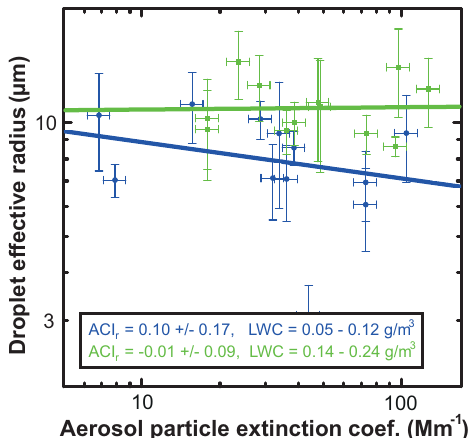
Figure 2. Cloud droplet effective radius (mean value for the height range from 30 to 70m above cloud base) vs. aerosol particle ex- tinction coefficient (mean value for the layer from 300 to 1000m below cloud base) for two LWC groups (green, blue). Twenty-six cloud cases are considered. The corresponding ACI r values (neg- ative slopes of the green and blue lines) are given as numbers to- gether with the standard deviations. The overall mean ACI r value is 0 . 04 ± 0 . 09. Vertical wind information is not considered in this analysis. Error bars show the uncertainties in the retrieved aerosol and cloud parameters. An error discussion is given in Schmidt et al. (2014).